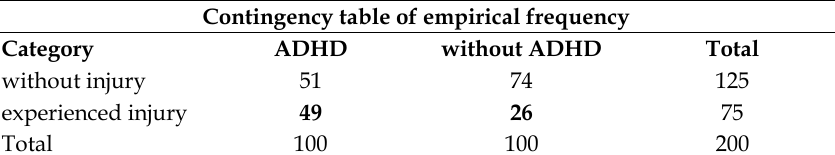
Table 1. Injury rates of ADHD and intact children compared (p-value=0,